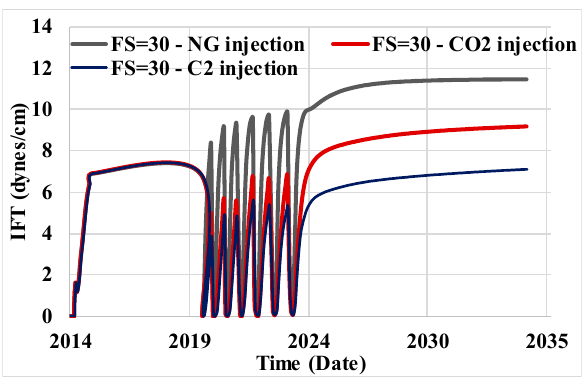
= 38 ◦ . 2 , C 2 H 6 and NG, Oil API